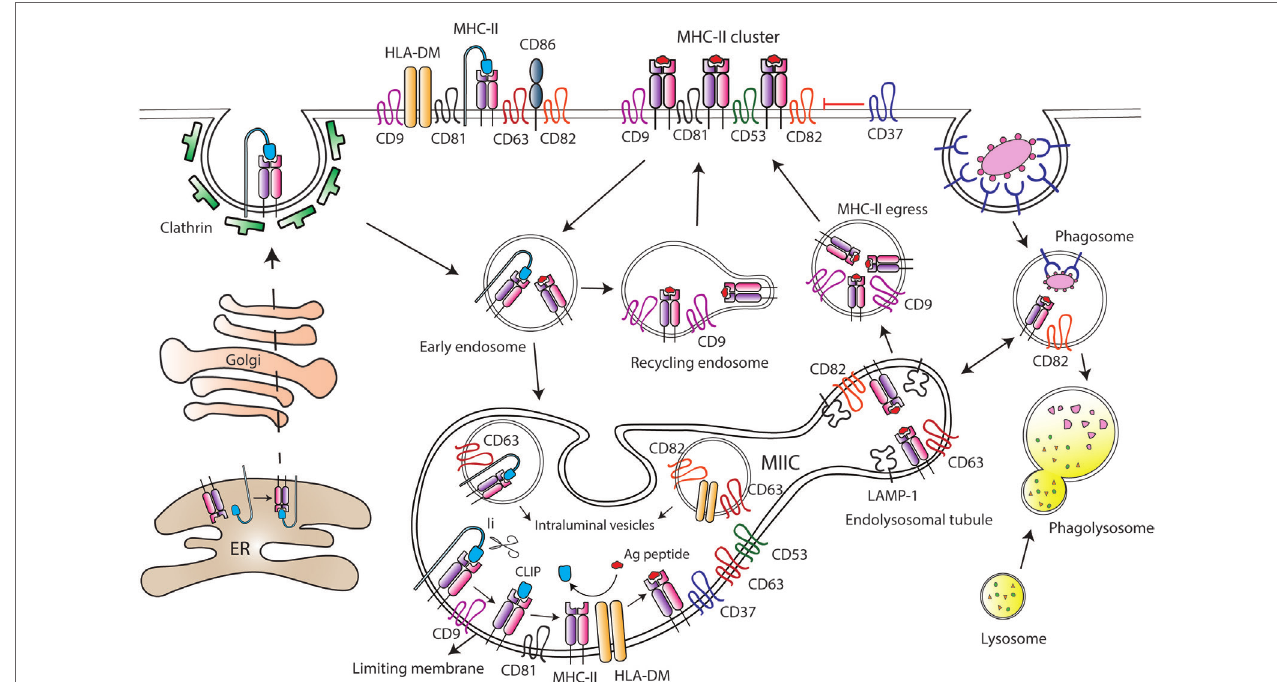
FigURe 3 | Tetraspanins regulate major histocompatibility complex class II (MHC-II) trafficking and surface expression at antigen-presenting cells (APCs). After synthesis, MHC-II molecules are transported to the plasma membrane of APCs in association with the chaperone Ii, which drives MHC-II internalization through clathrin-coated pits. Then, Ii is sequentially degraded by different proteases at the MHC-II-enriched endosomal compartment (MIIC), until MHC-II molecules remain bound only to the CLIP (class II-associated invariant chain peptide) fragment. Peptides derived from internalized antigens are subsequently loaded to MHC-II molecules with the help of the class-II-like chaperone HLA-DM. Several tetraspanins are greatly enriched at the MIIC compartment, and peptide-bound MHC-II molecules coupled to Ii are included into tetraspanin-enriched microdomains (TEMs). Tetraspanin CD9 is required for the efficient egress of MHC-II from MIIC to the cell surface, and it is essential for MHC-II endocytosis and recycling. CD82 together with CD63 accumulate in LAMP-1-enriched endolysosomal tubules that emanate from the MIIC. In MIIC intraluminal vesicles, CD63 is associated with MHC-II and HLA-DM; while CD82 only interacts with HLA-DM. In addition, CD82 is preferentially associated with peptide-bound MHC-II, and it is found in phagosomes prior to their fusion with lysosomes. At the APC surface, tetraspanins CD9, CD53, CD81, and CD82 are associated with MHC-II, and tetraspanin CD37 negatively regulates MHC-II clustering. Moreover, TEMs containing CD9, CD63, CD81, and CD82 include MHC-II, HLA-DM, and CD86